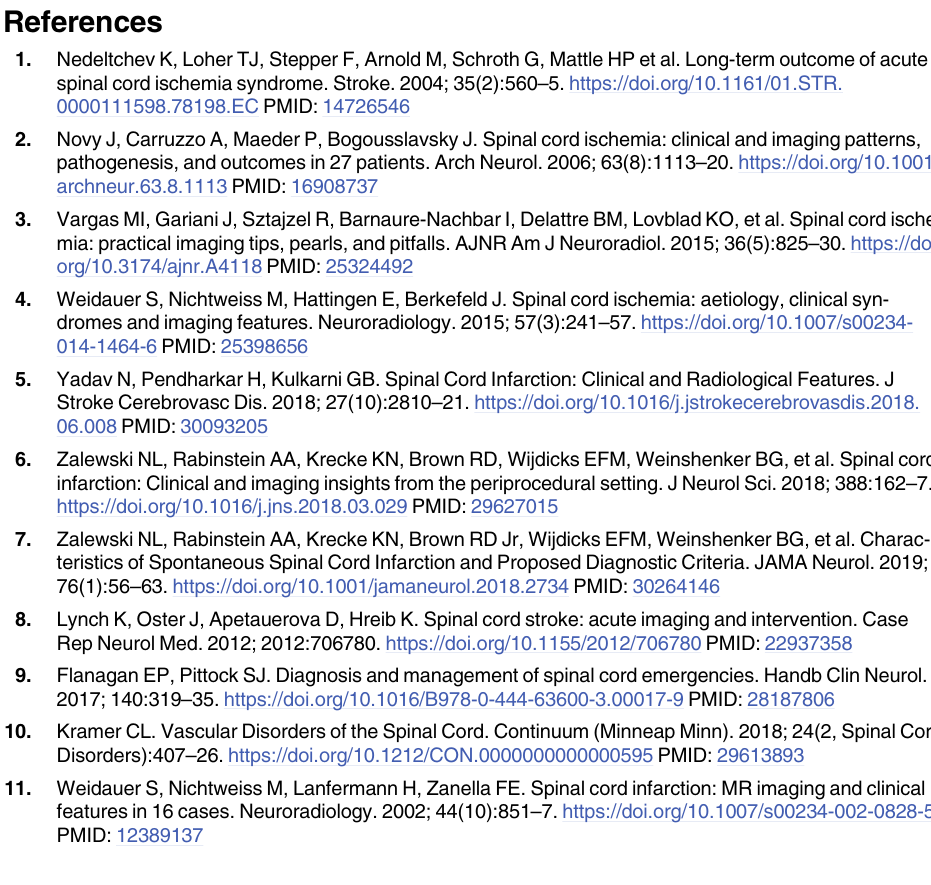
S1 Table. The confidence scores for diagnosing spinal cord infarction on T2WI. S2 Table. The confidence scores of usefulness of DWI for diagnosing spinal cord infarc-